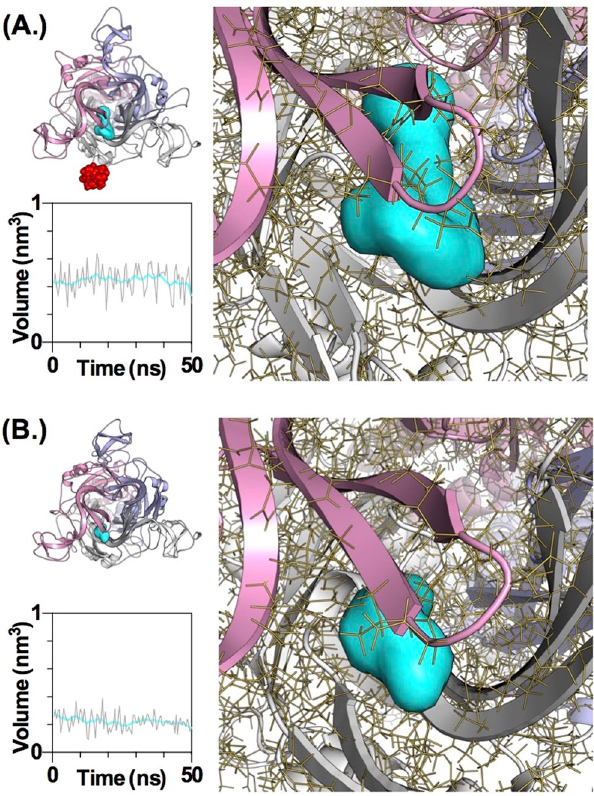
Figure 4. Molecular Dynamics Simulations of P2X7R and a P2X7R mutant with residues 73–79 deleted. ( A ) Variation of the size of the allosteric pocket in an MD simulation for the human P2X7R. A representative frame of the P2X7R MD simulation is shown in the top left panel (overview) and in the right panel (zoom). The P2X7R unique insertion region 73–79 is indicated as red spheres. The allosteric pocket as calculated in the mdpocket software is visualised as a cyan surface. In the bottom left panel the variation of the volume of the allosteric pocket during a 50 ns MD simulation derived from 100 frames is plotted as grey line, and with lowess fitting as the cyan line. ( B ) Variation of the size of the allosteric pocket in an MD simulation for the human P2X7R mutant without residues 73–79. Representation of data is as in ( A